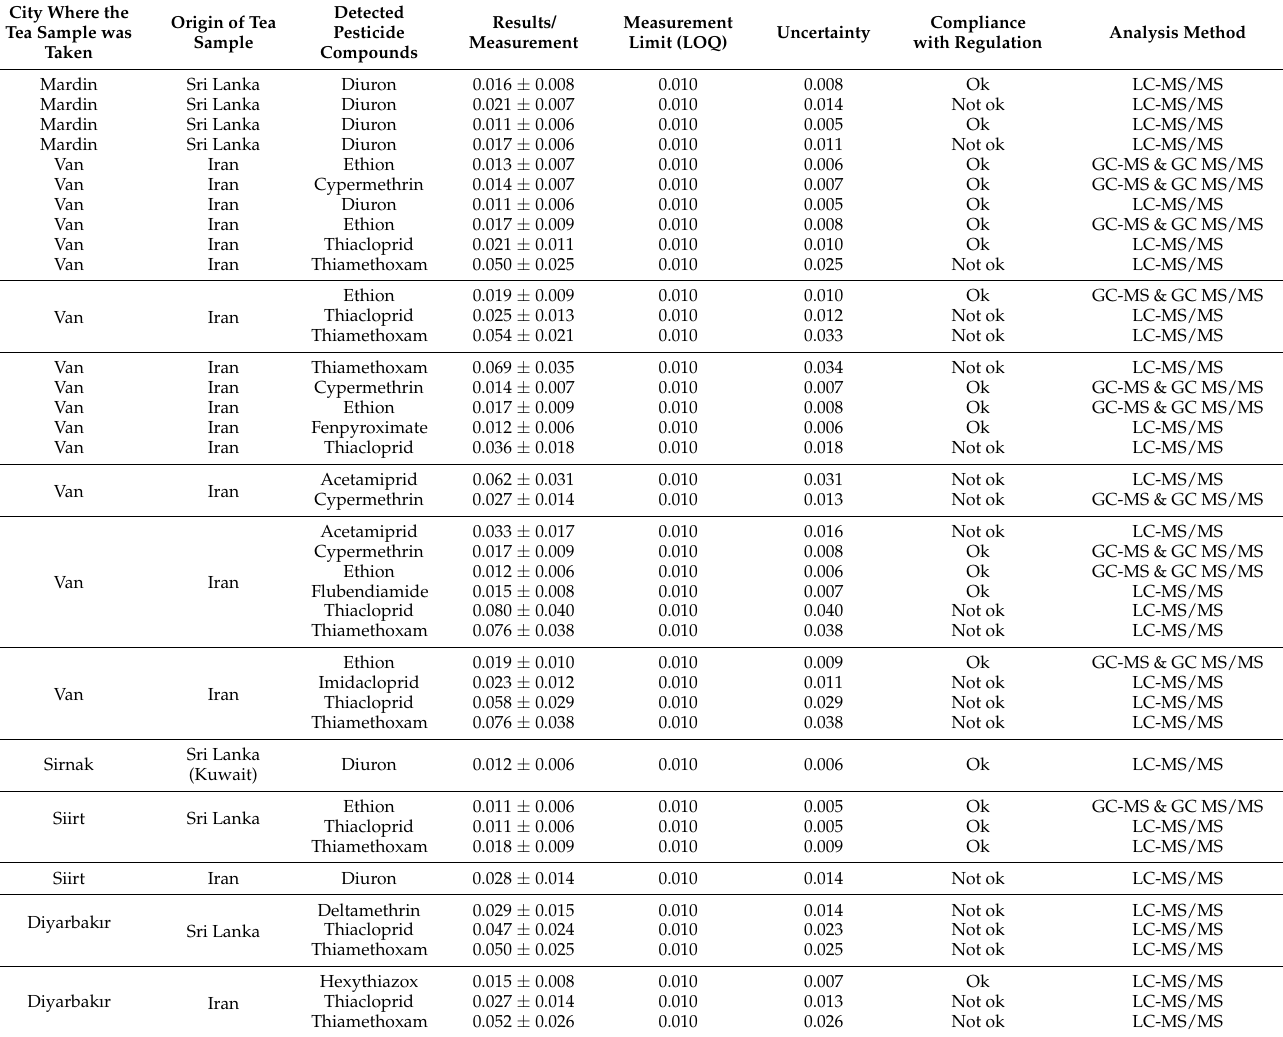
Table 1. LC-MS/MS and GC-MS(/MS) analysis of pesticide quantities determined and risk assess- ment according to Turkish Codex. Each sample was analyzed in triplicate. Results are given as mean ± standard deviation